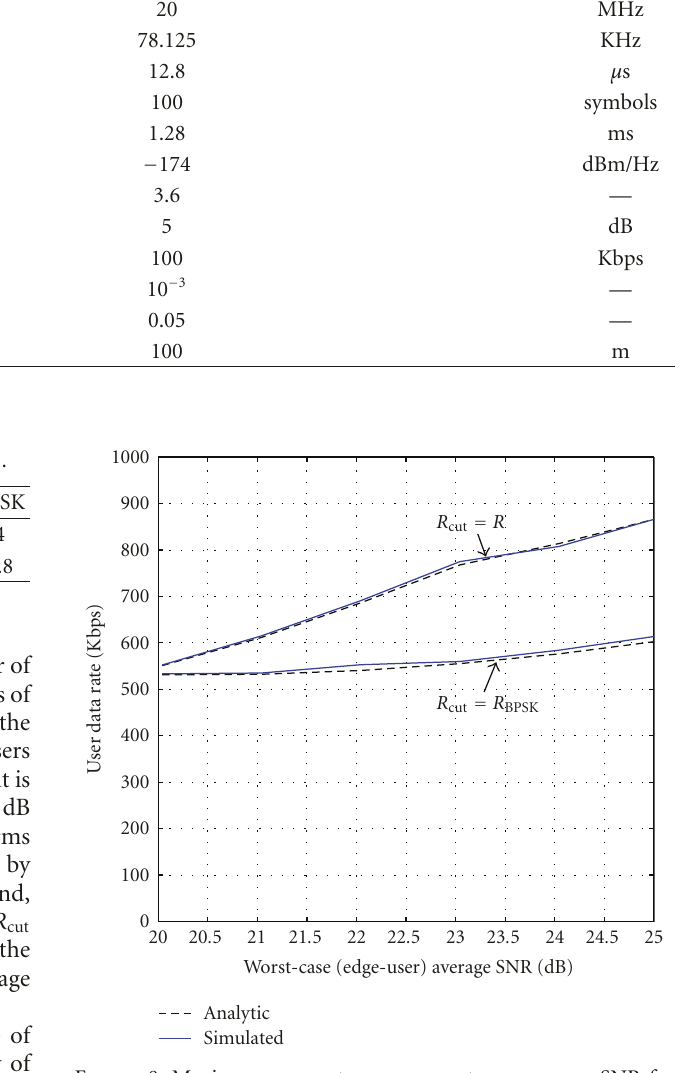
Figure 8: Maximum user rate versus worst-case average SNR for U = 100